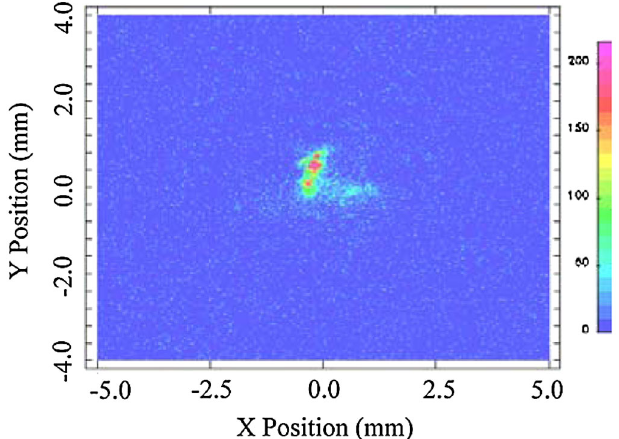
FIG. 8. (Color) OTR image at 375 MeV showing the enhance- ments are still present after acceleration beyond the bunch compressor.